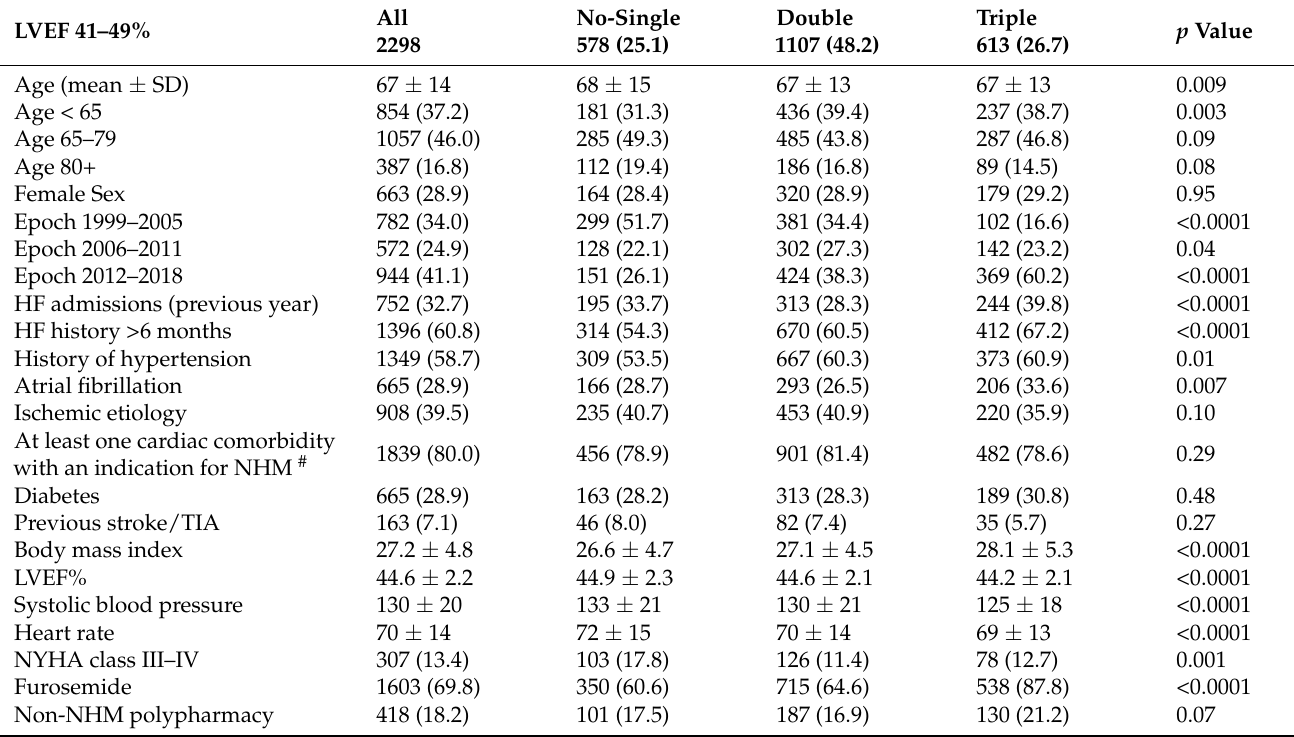
Table 1. Characteristics of HFmrEF patients according to conventional